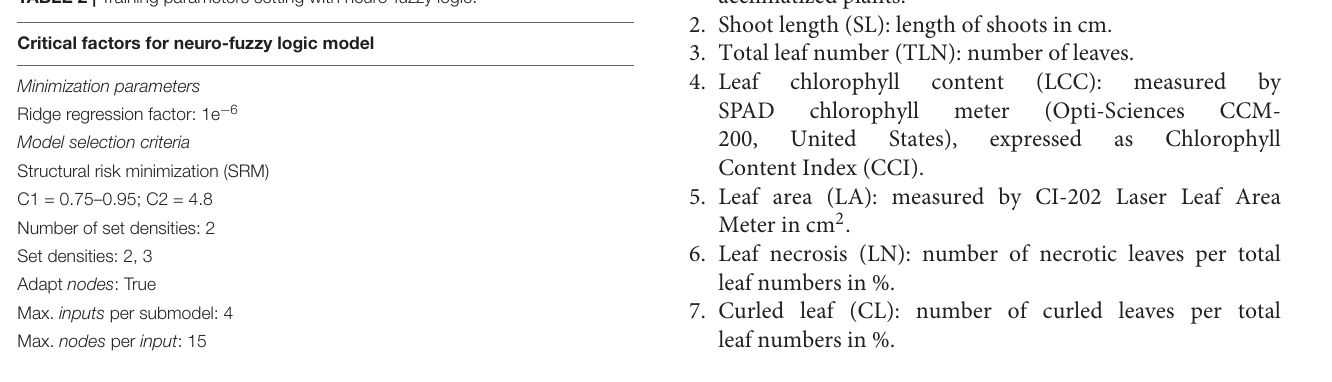
TABLE 2 | Training parameters setting with neuro-fuzzy logic.